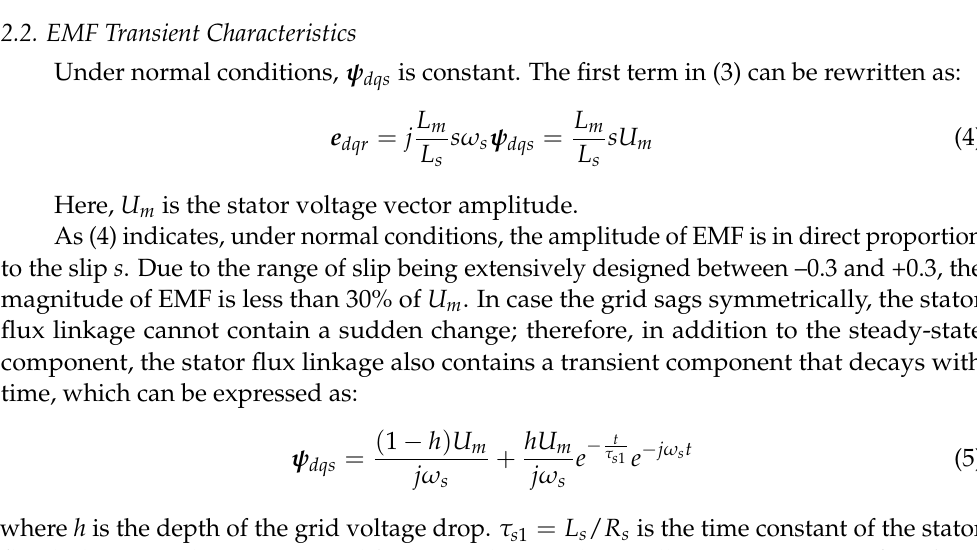
Figure 2. The equivalent circuit on the rotor